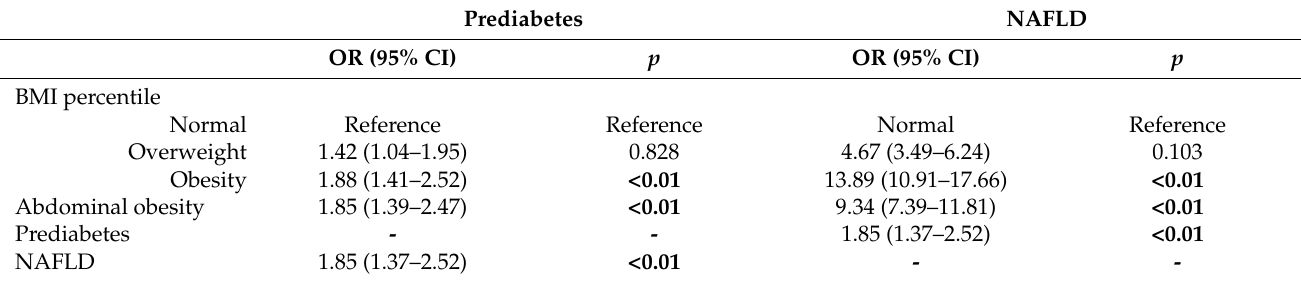
Table 4. Odds ratio of prediabetes and NAFLD according to each parameter.